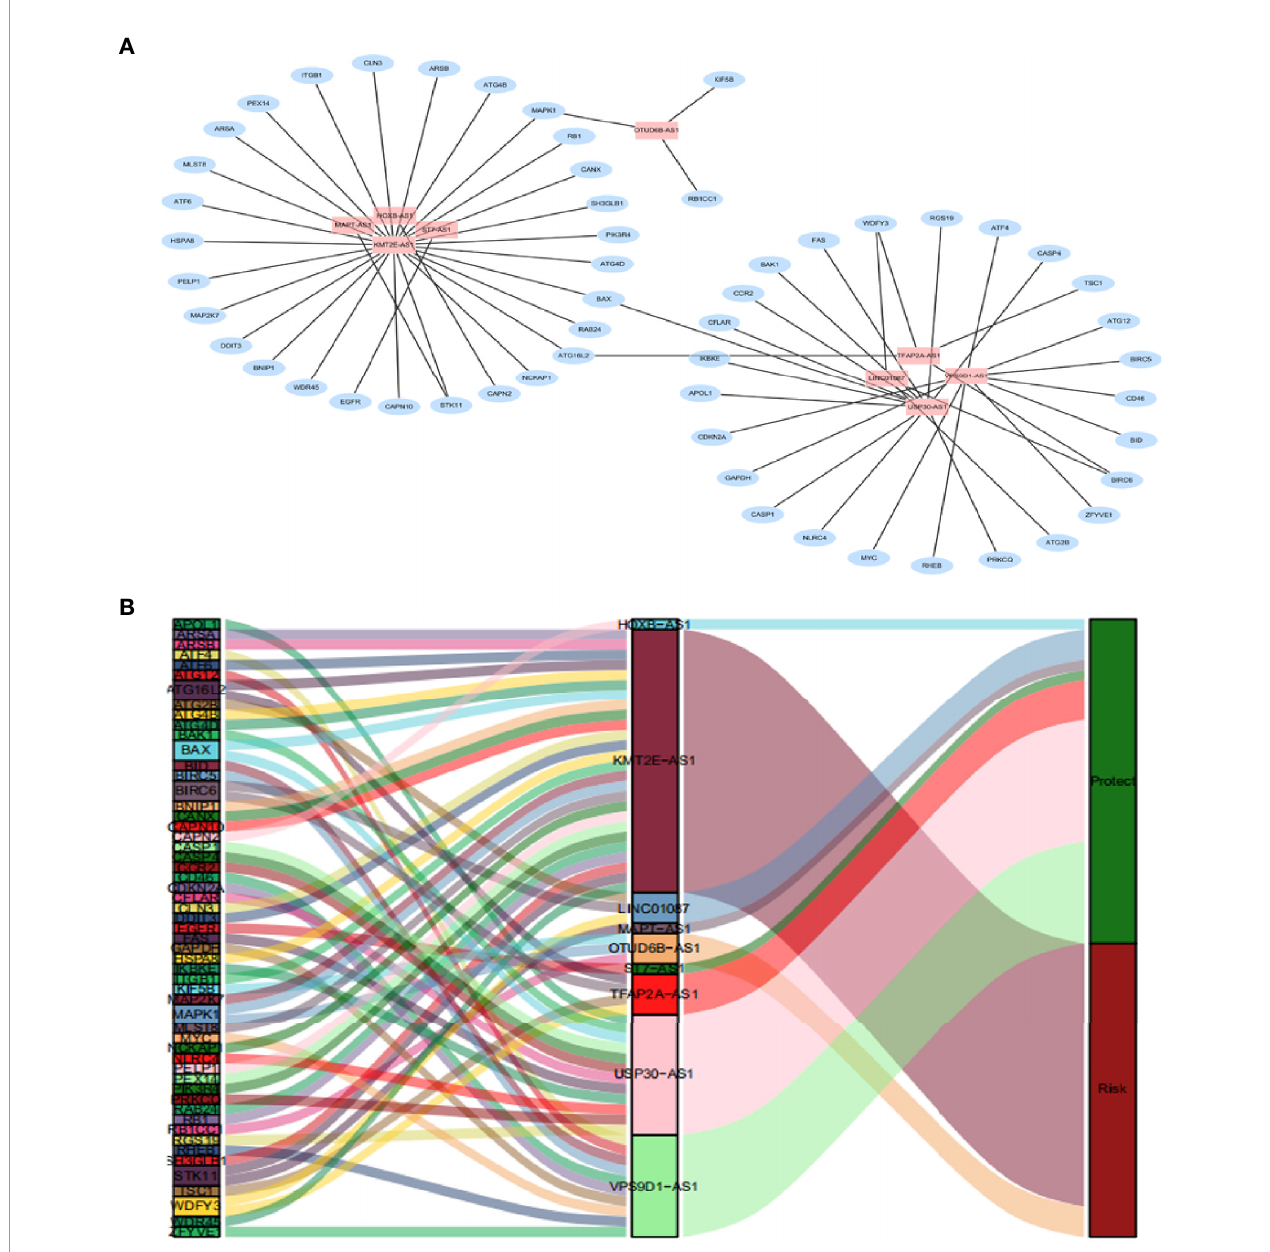
FIGURE 3 | A depiction of the regulation network of the prognostic lncRNAs and autophagy-related genes in breast cancer. (A) The blue nodes indicate autophagy genes and the pink nodes indicate lncRNA. The co-expression network is performed by CYTOSCAPE 3.7.2. (B) Among the risk types, the lncRNAs linked to dark green is protective lncRNAs, and dark red lncRNAs represents risk